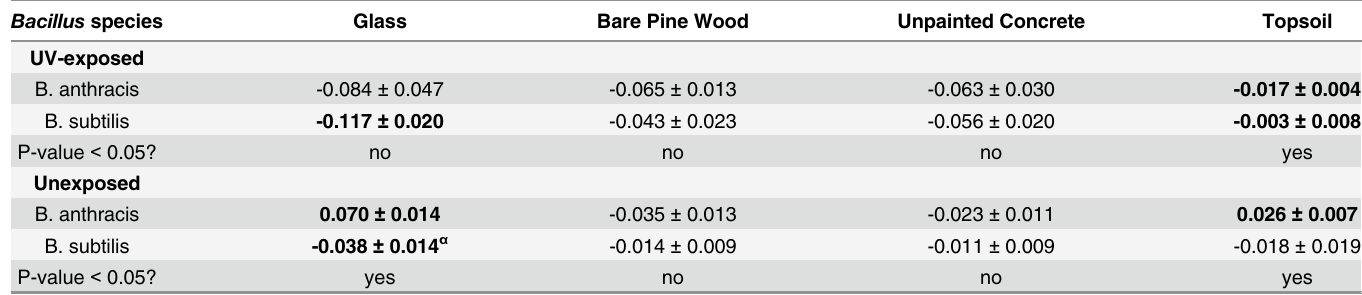
Table 3. Decay rates for second phase of spore